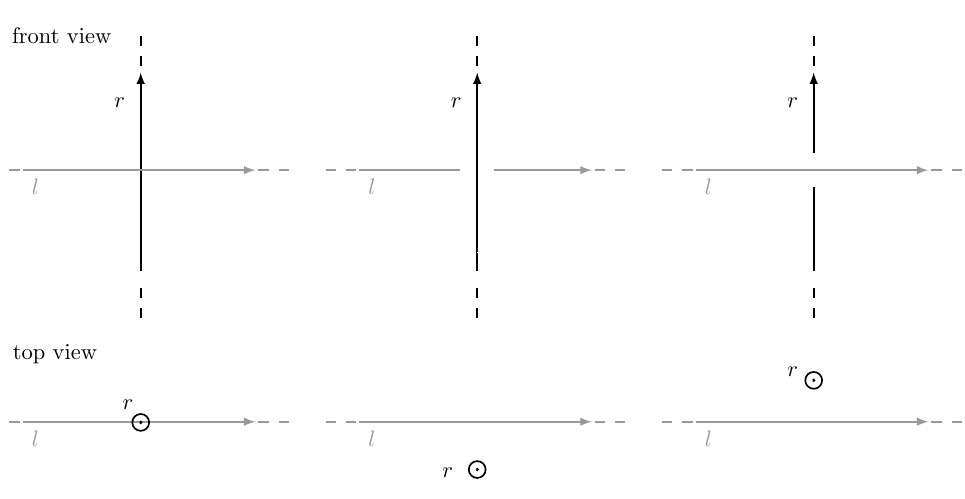
Figure 5. Possible line configurations in space: on the left l and r intersect, in the middle l goes clockwise around r while on the right l goes counter-clockwise around r